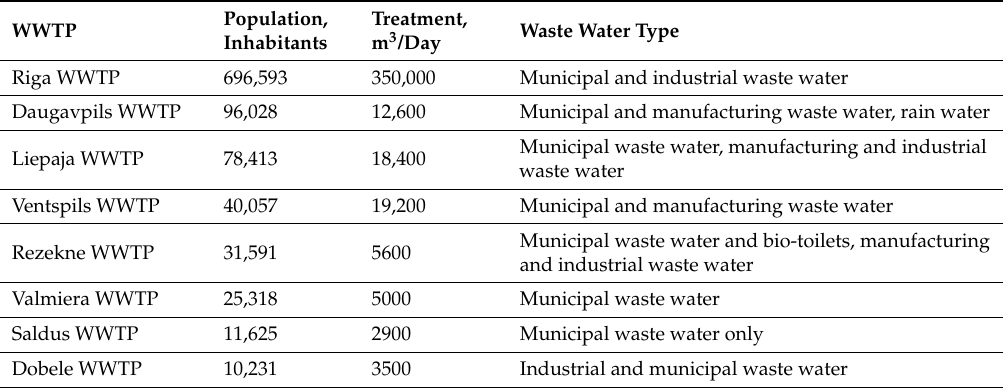
Table 1. General information on city-size, waste water type, and the amount treated by WWTP.